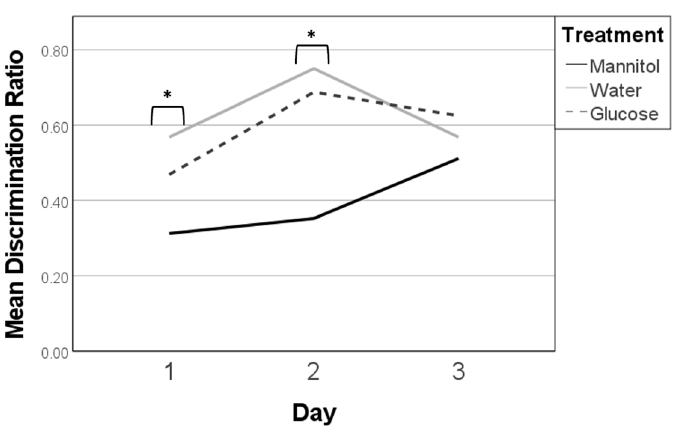
Figure 8. Discrimination ratios in the 12-week washout experiments. Discrimination ratios were calculated on all three 12-week reversal days (day 1, day 2, day 3). In this experiment, fish were exposed to hyperglycemic conditions for 8 weeks, followed by 4 weeks in normglycemic (system water) conditions. Significant differences in discrimination ratios were observed on days 1 and 2, when the responses of mannitol treated fish were lower than responses of fish in the glucose- or water-treatment groups (one-way ANOVA, F (2,82) = 7.051, p = 0.001, *). However, subsequent trendline analysis did not identify any significant differences across reversal days.